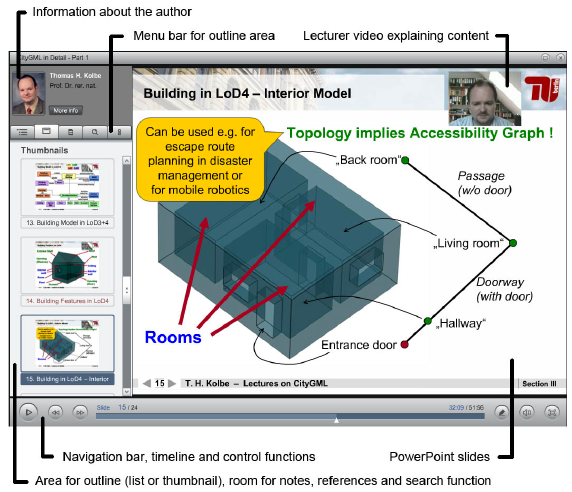
Figure 3: Lecture-on-demand screen